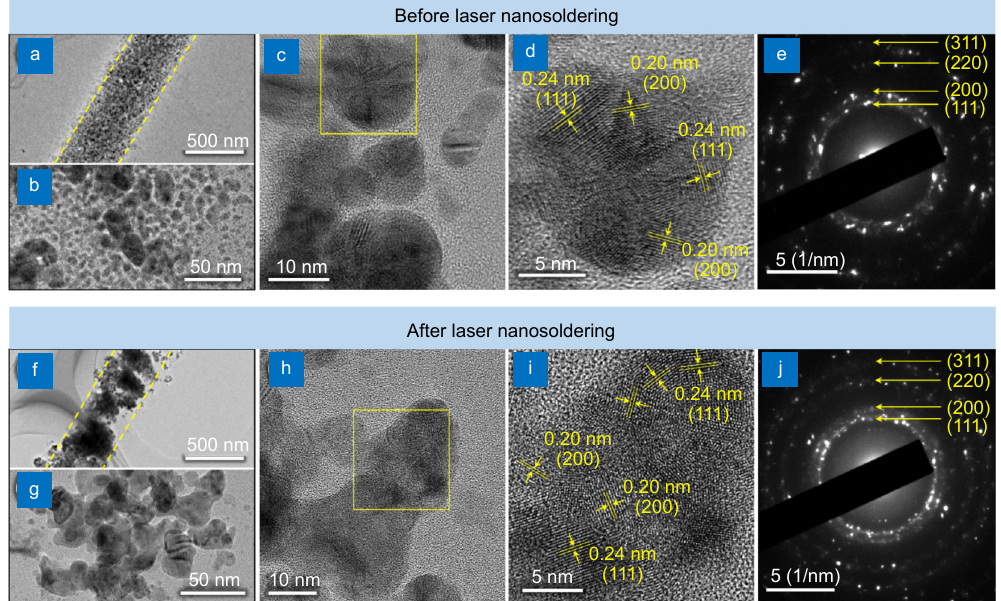
Fig. 2 | TEM images of Ag NWs for overall ( a ), local ( b ) and magnified ( c ) topographies before the laser illumination. ( d ) Typical HRTEM images and ( e ) SAED patterns of Ag NPs before the laser illumination. TEM images of Ag NWs for overall ( f ), local ( g ) and magnified ( h ) topographies after the illumination. ( i ) Typical HRTEM images and ( j ) SAED pattern of Ag NPs after laser illumination for 15